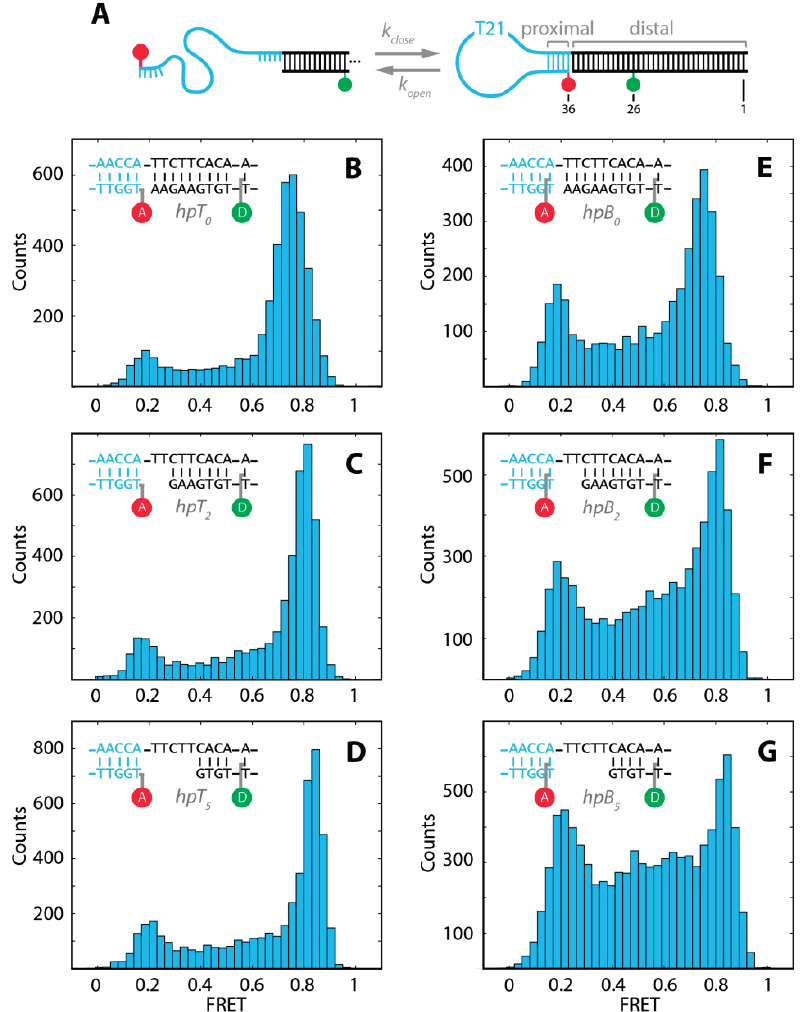
Figure 1. ( A ) Schematic for the conformational fluctuation of the stem-loop DNA hairpin between closed and open states with the characteristic opening rate and closing rate, k , respectively .The basic DNA hairpin consists of a T21 loop and a 5 bp proximal stem k close (5'-AACCA-3'), followed by a 25–30 bp long distal stem. All constructs were labeled at position 26 with ATTO532 and at position 36 with ATTO647N; ( B – G ) FRET efficiency histograms of the six different DNA hairpins after removal of donor-only and acceptor-only populations and photobleaching events (see